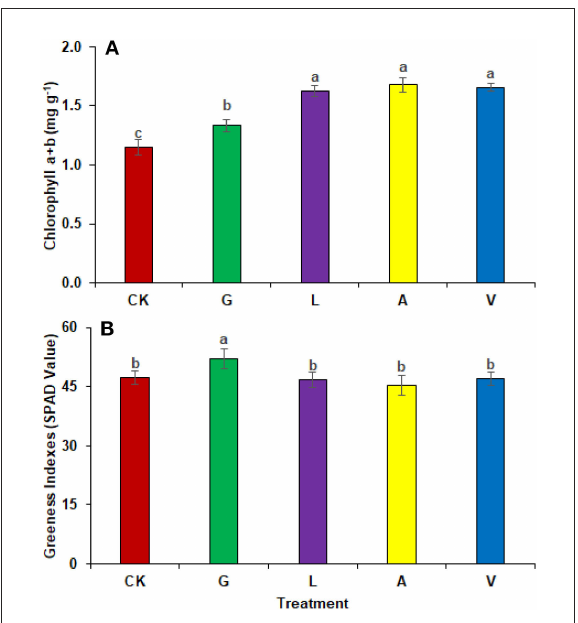
FIGURE2 Plant weight and moisture content: (A) Plant fresh weight, (B) Plant dry weight, (C) Moisture content observed in experiment 1 using chemical fertilizer (CK), glycine (G), lysine (L), aspartic acid (A), and vitamin B complex (V). The values mentioned herein are indicated as mean ± S.D and the lowercase letters indicate the significant difference among the